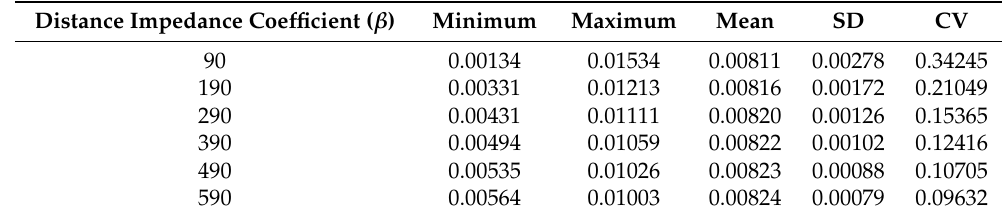
Table 4. The descriptive statistics of the results.